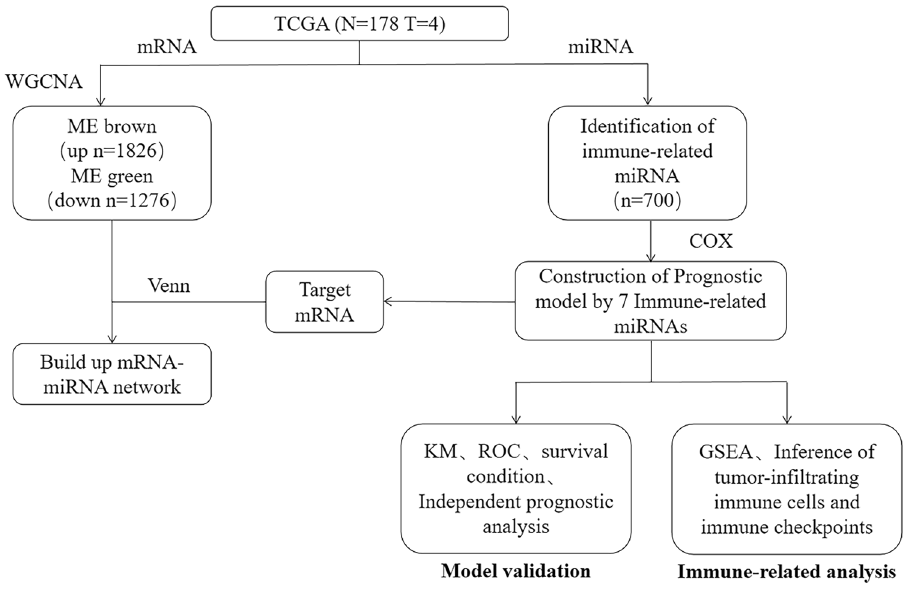
Figure 1. The flow